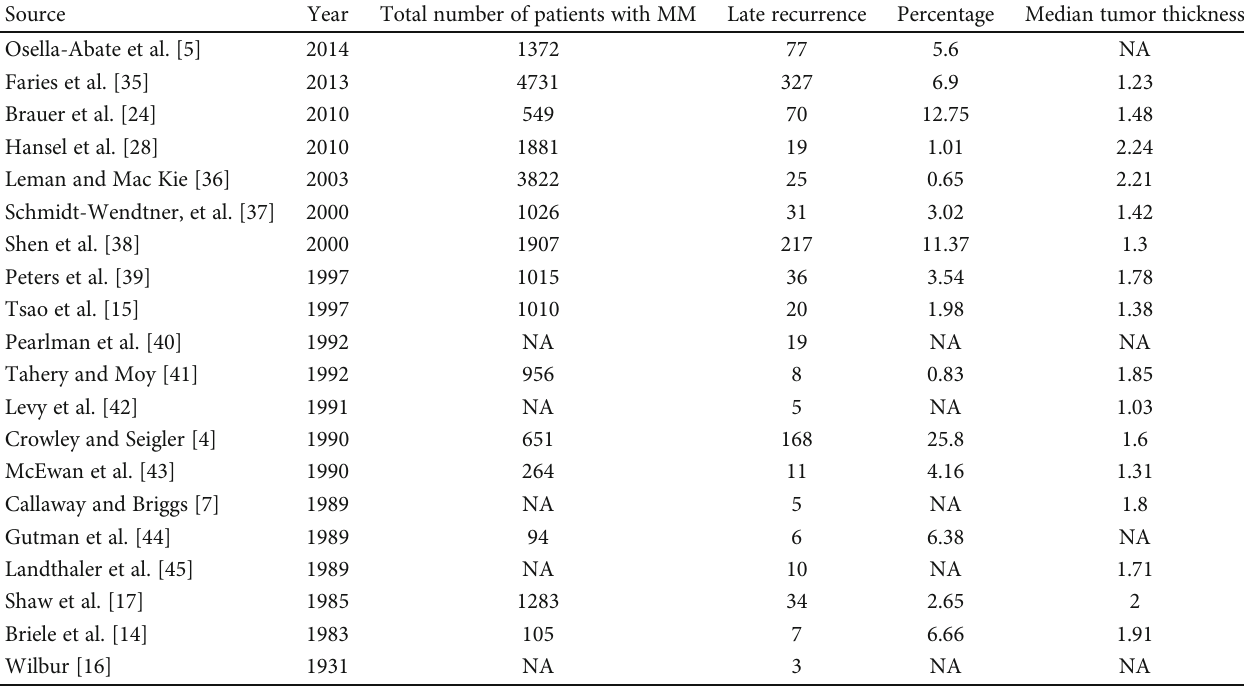
Table 1: List of publications regarding the frequency of late metastases (usually > 10 years) from CMM (based on Farie et al.).